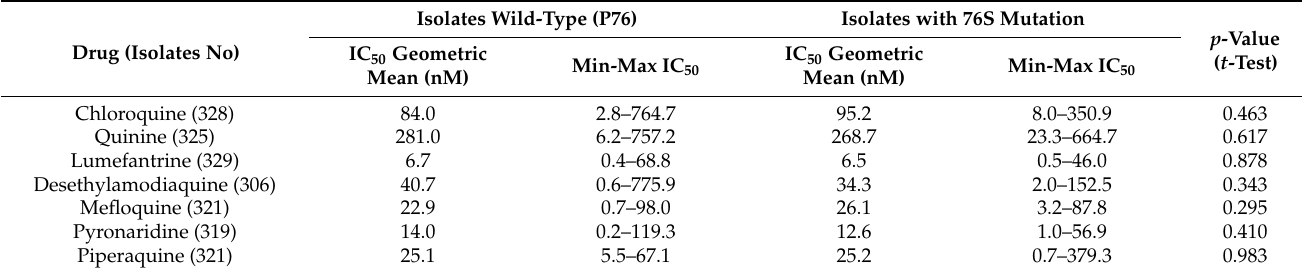
Table 3. Ex vivo susceptibility geometric mean to chloroquine, quinine, lumefantrine, desethylamodiaquine, pyronaridine, and piperaquine according to the pfcoronin genotype (P76 or 76S).